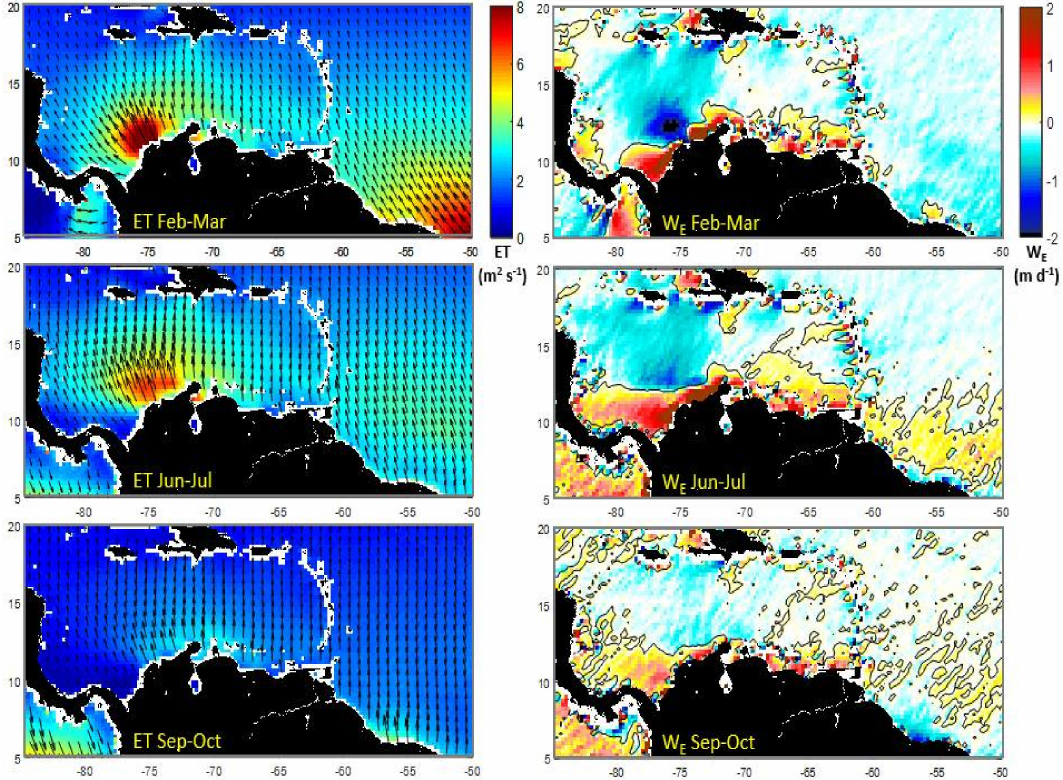
Figure 4. Seasonal averages of Ekman transport (ET, left) and Ekman pumping/suction velocity (W E , right) in the Caribbean Sea. Seasonal averages for the peak of the principal upwelling (February–March), the peak of the mid-year upwelling (June–July), and for the minimum upwelling season (September–October). ET and W E were derived from the QuikSCAT satellite-based sensor (1999–2009). The southern Caribbean upwelling system had year-round offshore ET and positive W E (positive/negative W E induces open-sea upwelling/downwelling). During the mid-year upwelling, positive W E was higher and with a wider offshore extension. ET magnitude/direction is denoted by color/arrows. W E equaling zero is denoted by the black